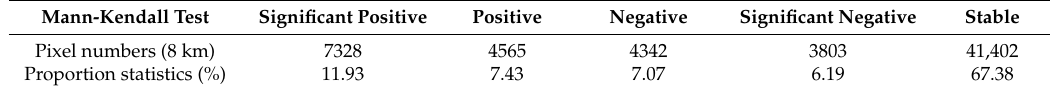
Table 3. Statistics of significant effects for human-induced vegetation change.